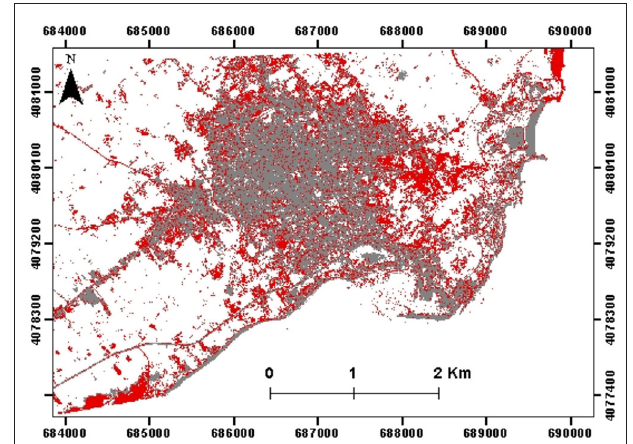
FIGURE 3 | The urban change detection map of Otsu Threshold Segmentation method showing urban expansion of Kelibia city in 2016 (red) on the basis of the urban extent of 2012